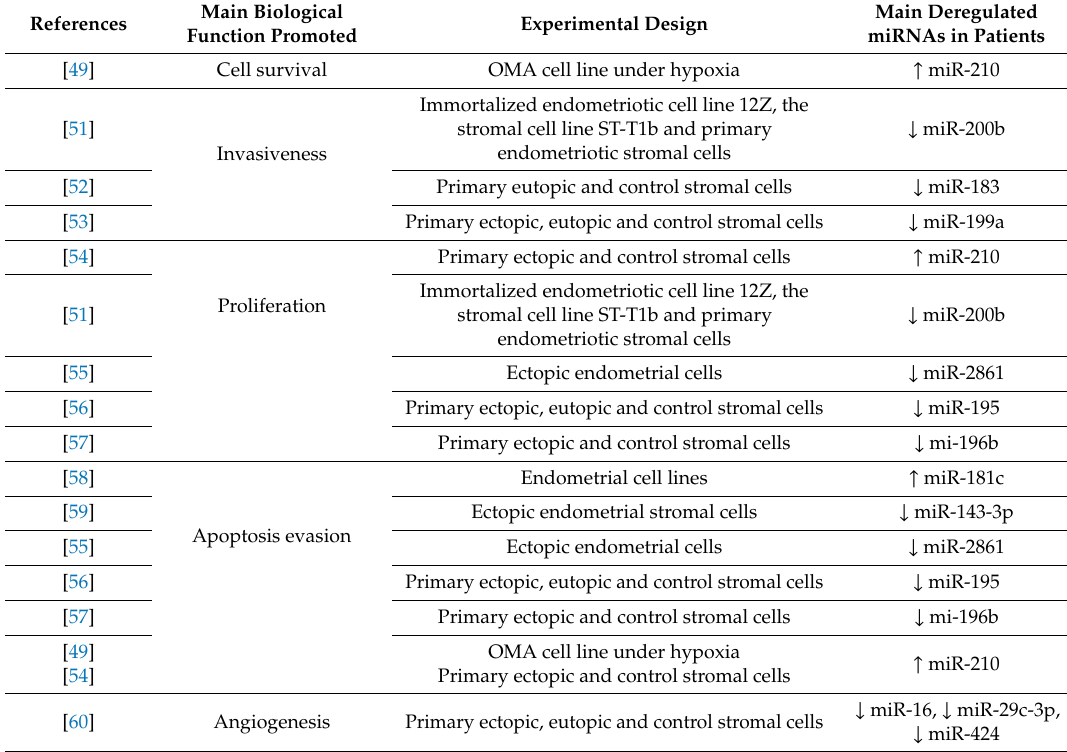
Table 1. Deregulated miRNAs in selected in vitro studies in